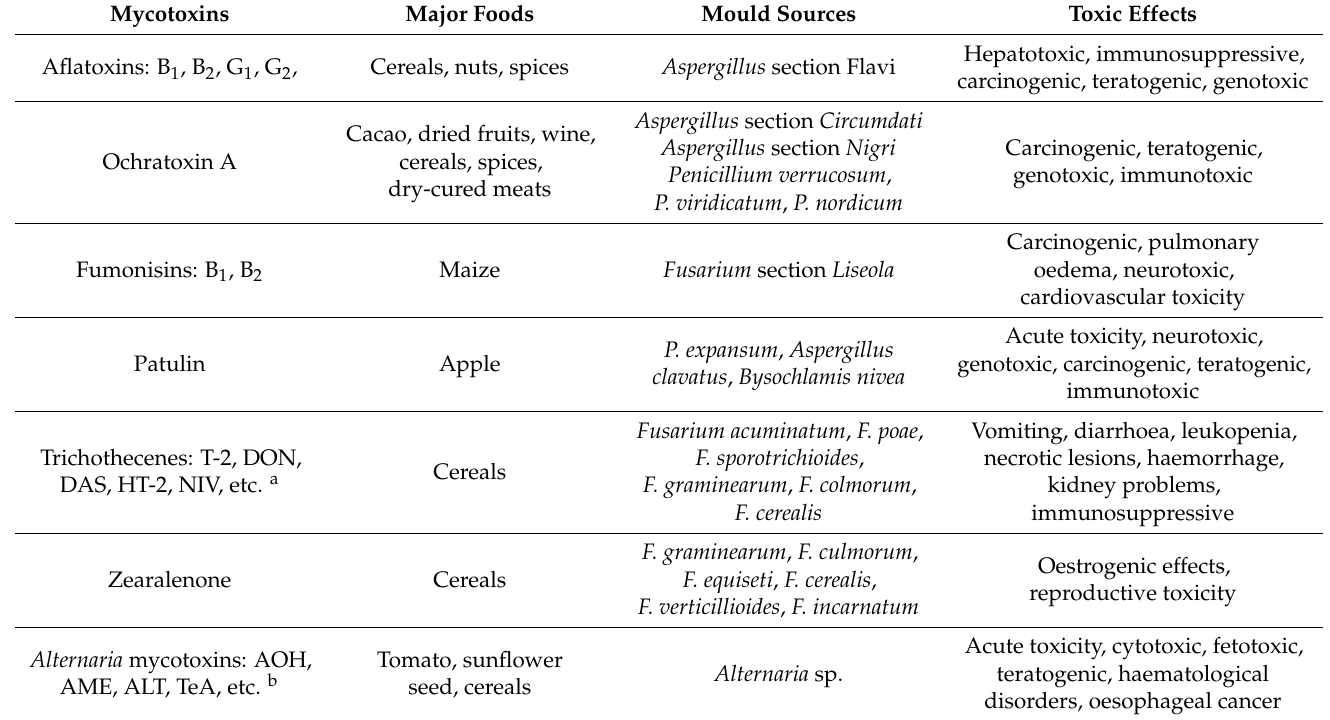
Table 1. Some important foodborne mycotoxins, commodity of origin, main producing moulds, and toxic effects on human health